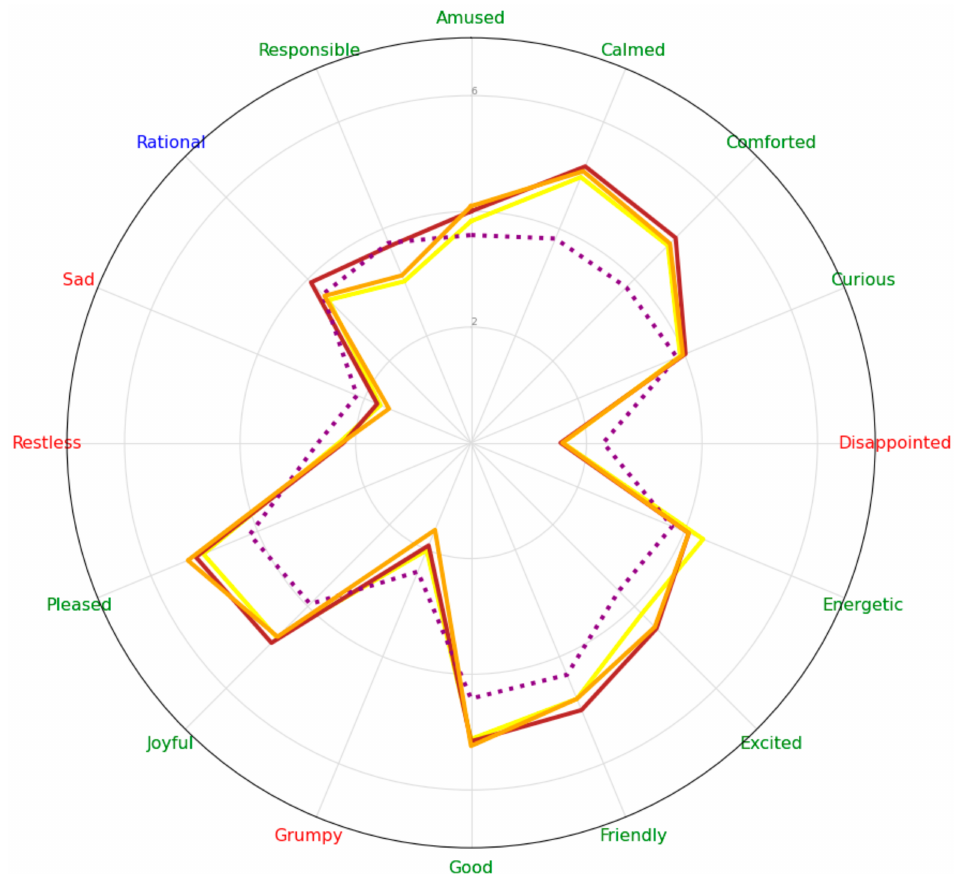
Figure 4. Radar chart with the mean averages of auditory conditions for every emotion score in Experiment 2. The purple/dotted-line represents the no-sound condition. The brown line, the low- pressure one. The yellow line, the low-frequency sound condition. The orange line, the unaltered sound condition.